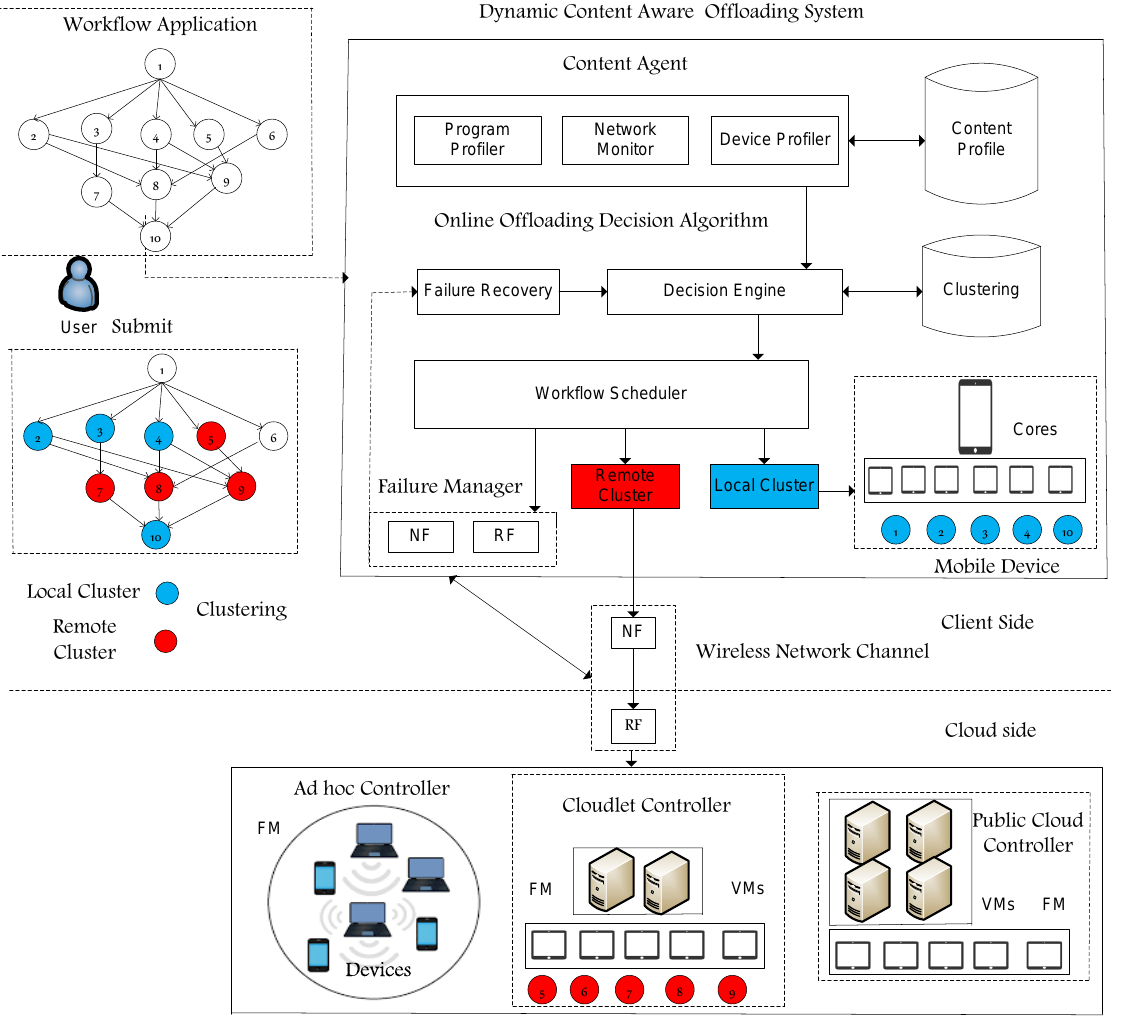
Figure 1. Modified mob-cloud Architecture